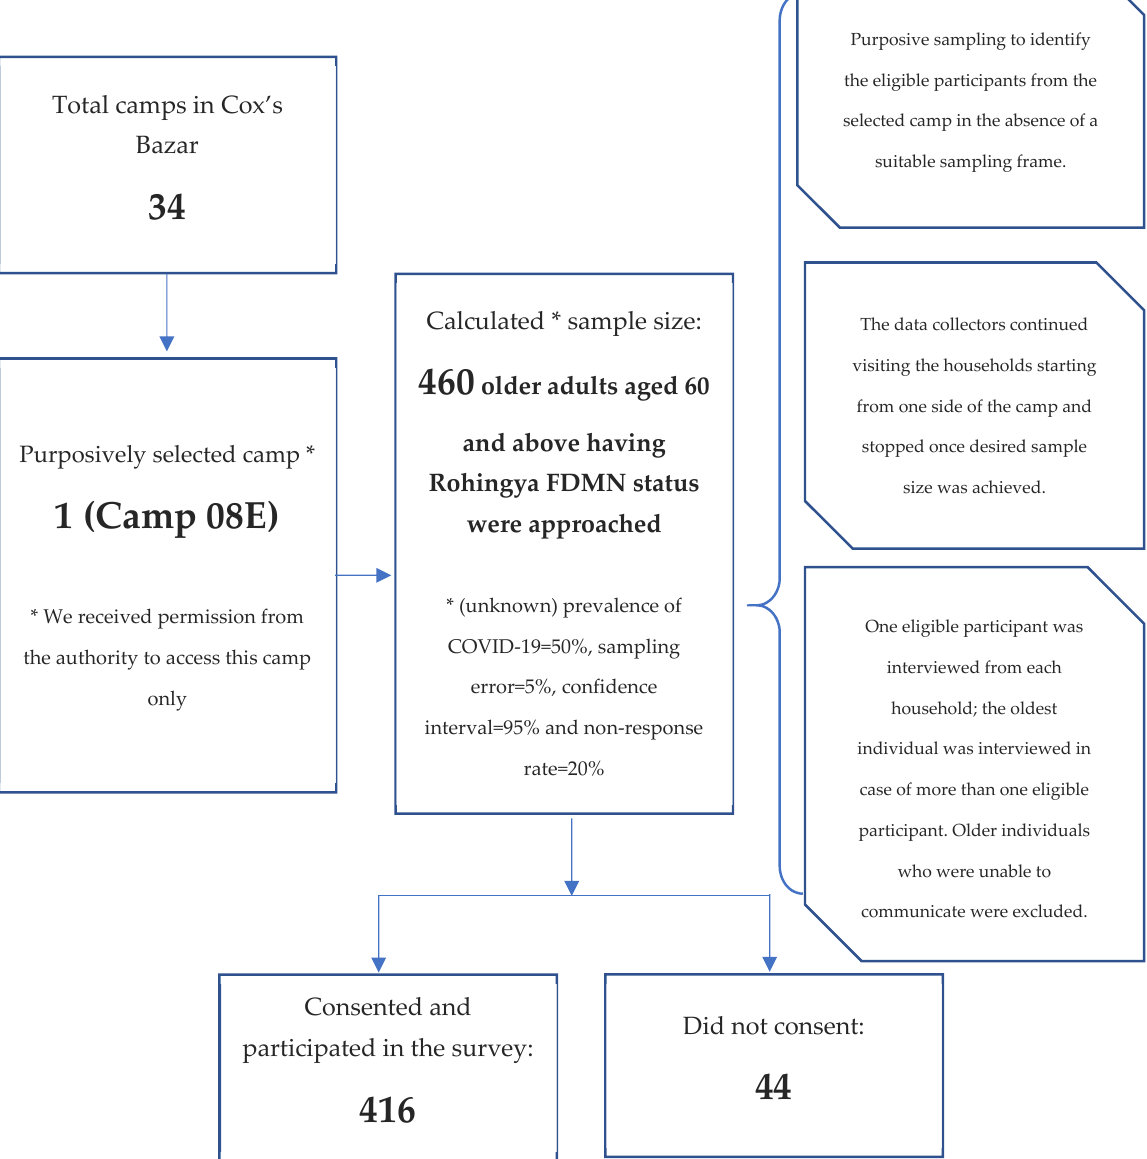
Figure 1. Sample selection and study participants.